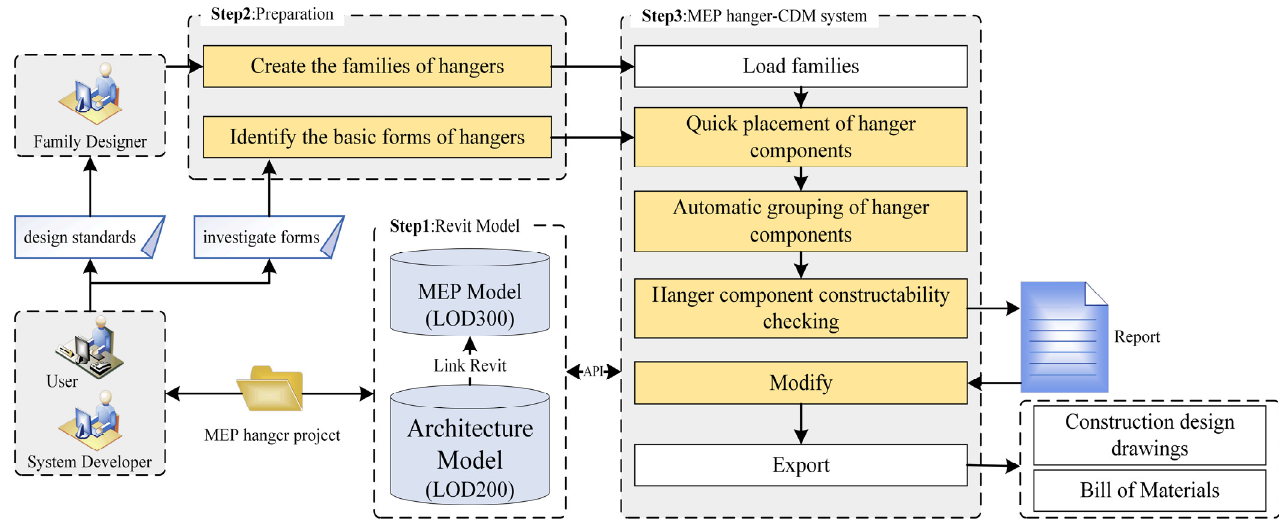
Figure 1. The framework of this study.